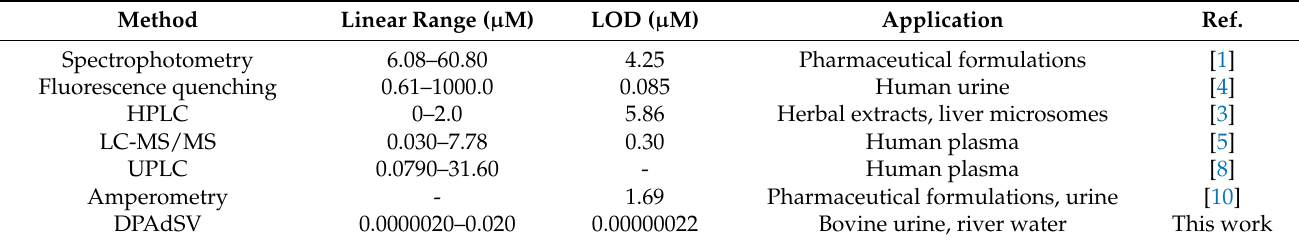
Table 1. Comparison of different methods for RIF